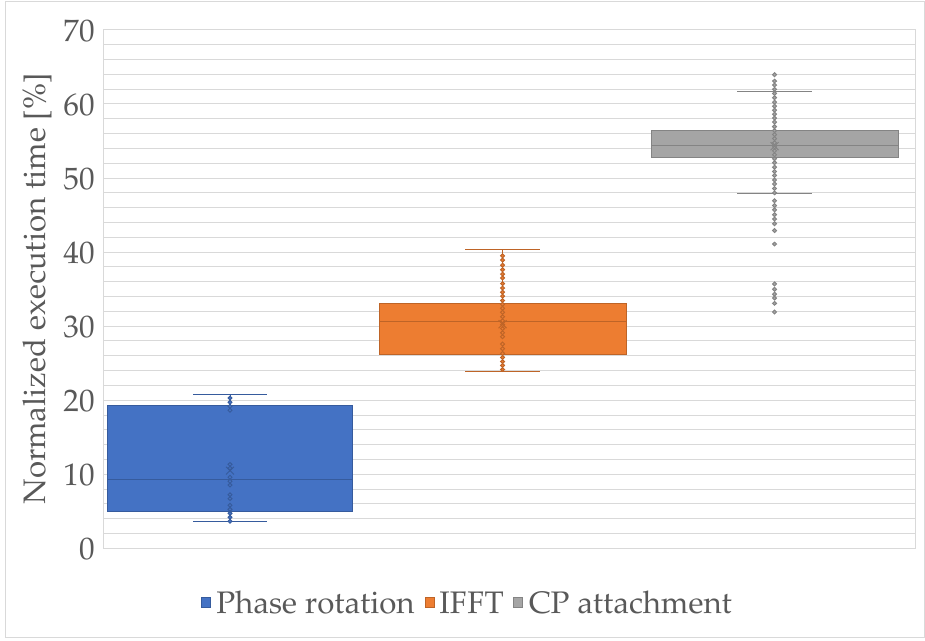
Figure 9. Normalized execution time of the OFDM generation decomposed functions. Table 8. Normalized execution times of the framework modules and decomposed